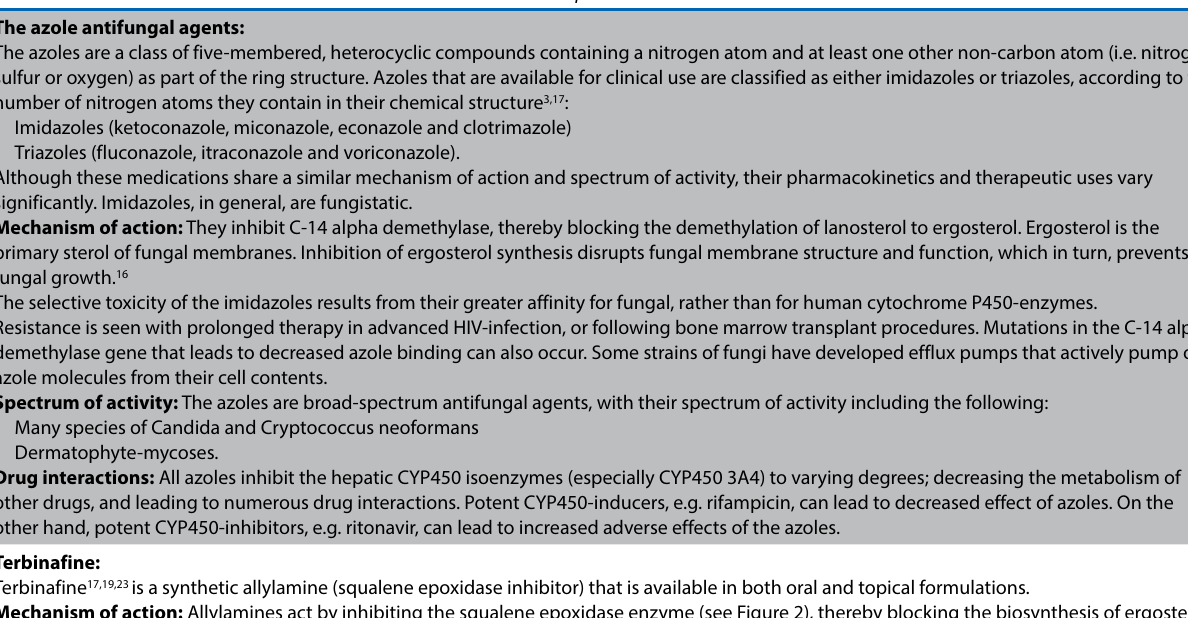
Table 2: An overview of the medication most often used to treat tinea pedis 3,16-20,22-24 The azole antifungal agents: The azoles are a class of five-membered, heterocyclic compounds containing a nitrogen atom and at least one other non-carbon atom (i.e. nitrogen, sulfur or oxygen) as part of the ring structure. Azoles that are available for clinical use are classified as either imidazoles or triazoles, according to the number of nitrogen atoms they contain in their chemical structure 3,17